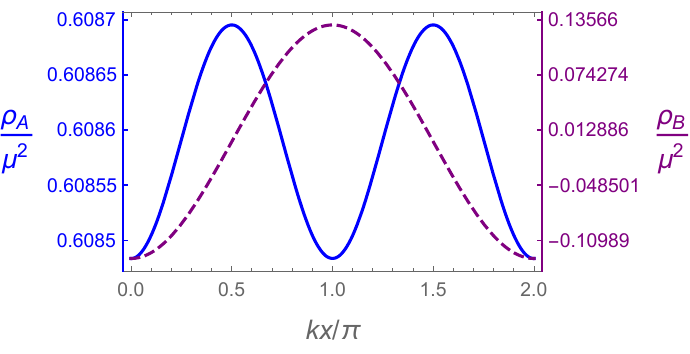
Figure 9 . The two charge densities for q B = 0, T = 0 : 01426 and k = 1. Here the frequency of (cid:26) A is twice that of (cid:26) B (and consequently of the scalar condensate).